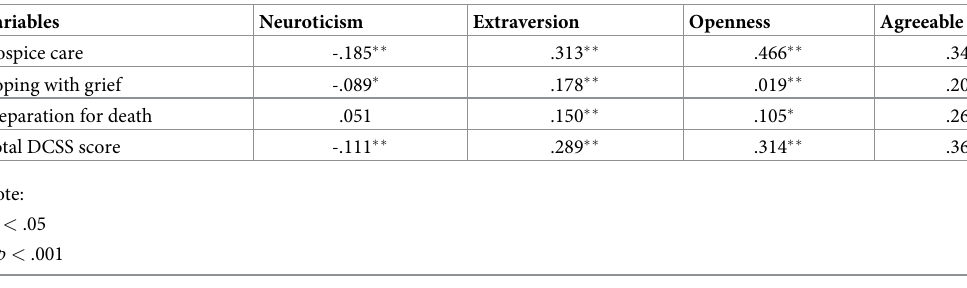
Table 4. Correlations between the Big Five Personality Traits and death coping self-efficacy scores.